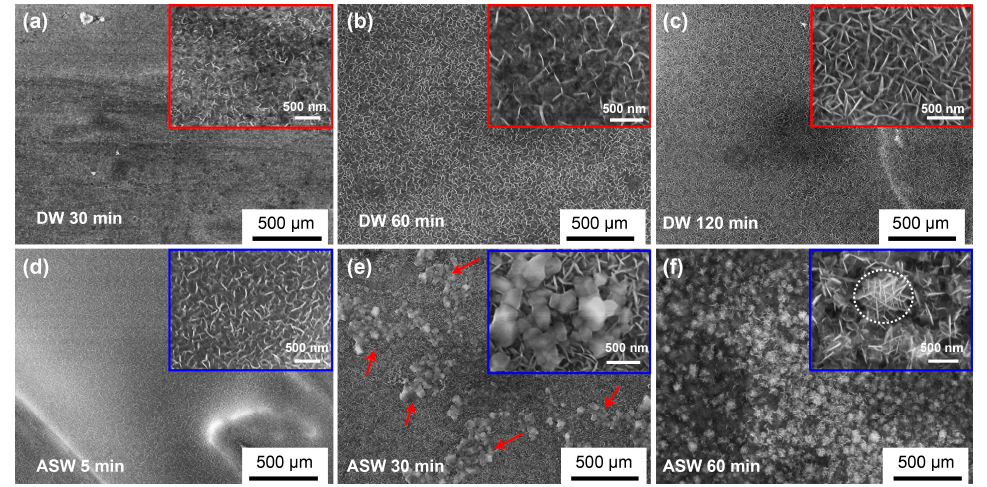
Figure 1. The surface morphology of MZC MG (Mg-Zn-Ca metallic glass) ribbon after being teated for different times in DW (deionized water) solution ( a – c ) and ASW (artificial seawater) solution ( d – f ), with an inset in each picture showing its respective high-magnification image.